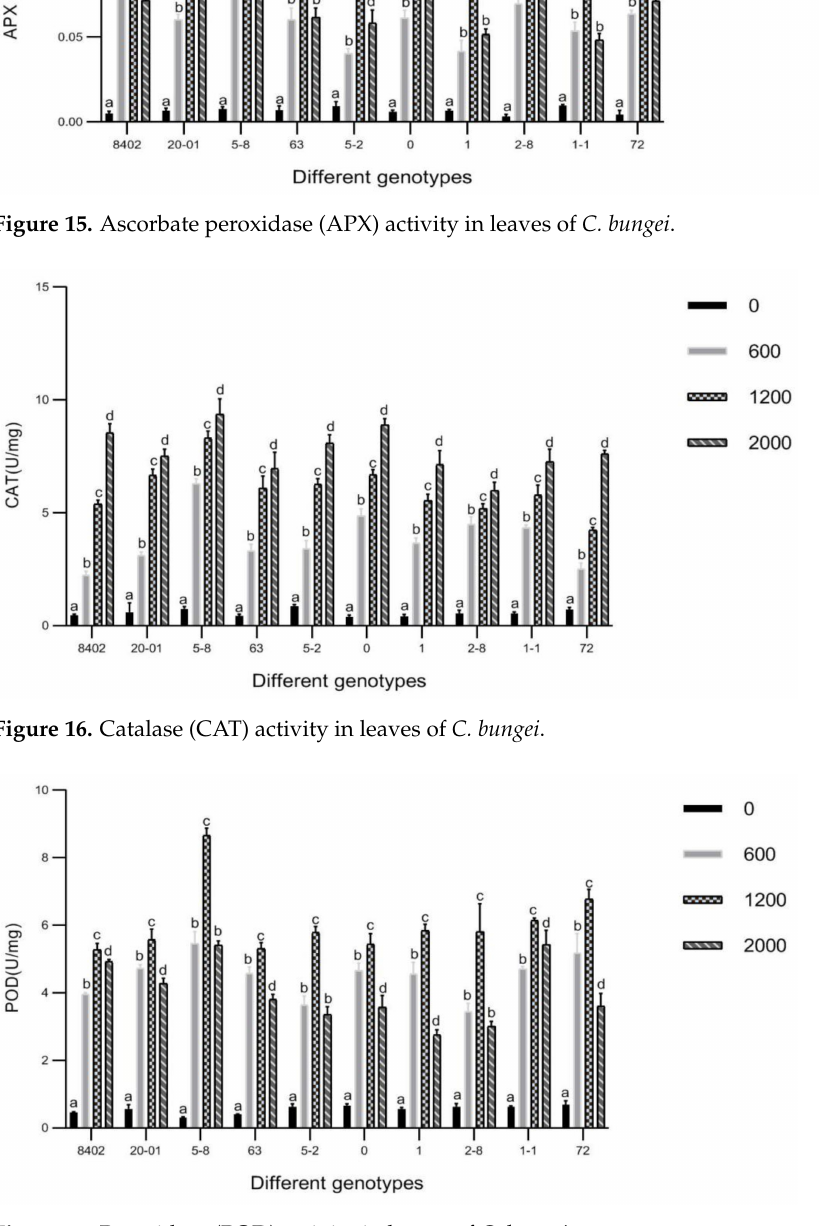
Figure 17. Peroxidase (POD) activity in leaves of C. bungei